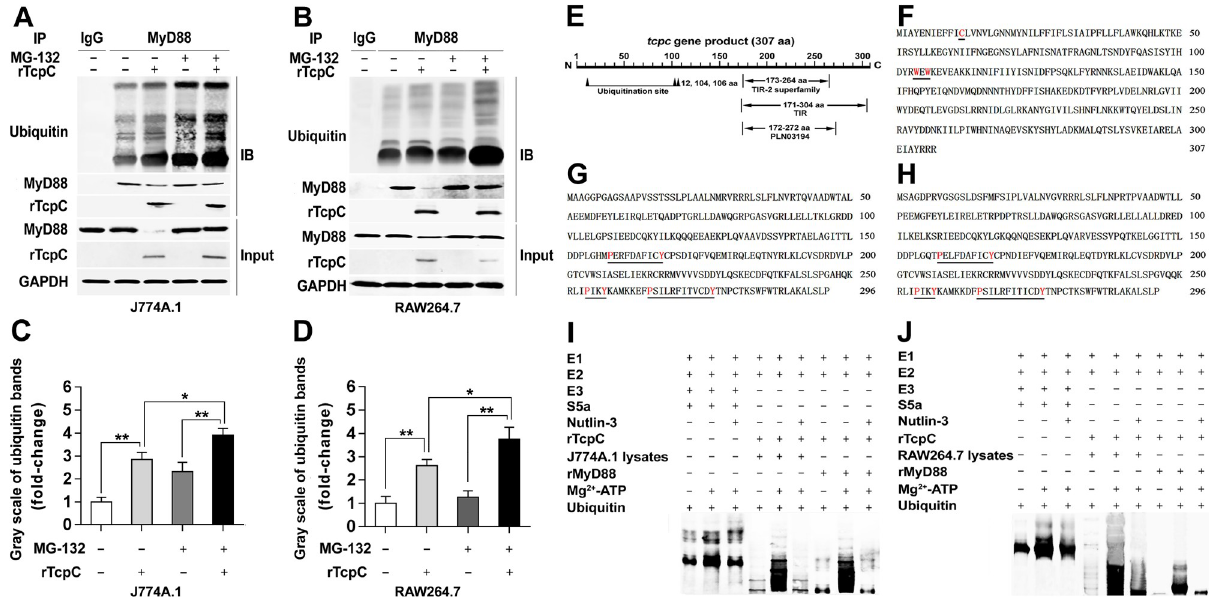
Fig 4. rTcpC is a MyD88-targeted E3 ubiquitin ligase. (A-B) Co-immunoprecipitation and Western blot to detect the degradation and ubiquitination of MyD88 in lysates of J774A.1 and RAW264.7, respectively. (C-D) Gray scale analyses of ubiquitination of MyD88 bands in lysates of rTcpC treated J774A.1 and RAW264.7, respectively. Mean ± SD of three independent experiments were shown. The ratio of ubiquitination to protein level of MyD88 in cells without rTcpC treatment was set as 1.0. � : p < 0.05; �� : p < 0.01. (E) Predicted functional domains in tcpc gene. (F) Predicted HECT E3 ubiquitin ligase enzyme sites in amino acid sequence of TcpC. (G-H) Predicted interaction sites of HECT E3 ubiquitin ligase substrate in amino acid sequence of human and mouse MyD88, respectively. (I-J) Ubiquitination kit tests to detect the E3 activity of rTcpC. S5a, an E3 ubiquitin ligase enzyme substrate was used as the control. rTcpC was used as the E3 when lysates from J774A.1 and RAW264.7 and rMyD88 used as the